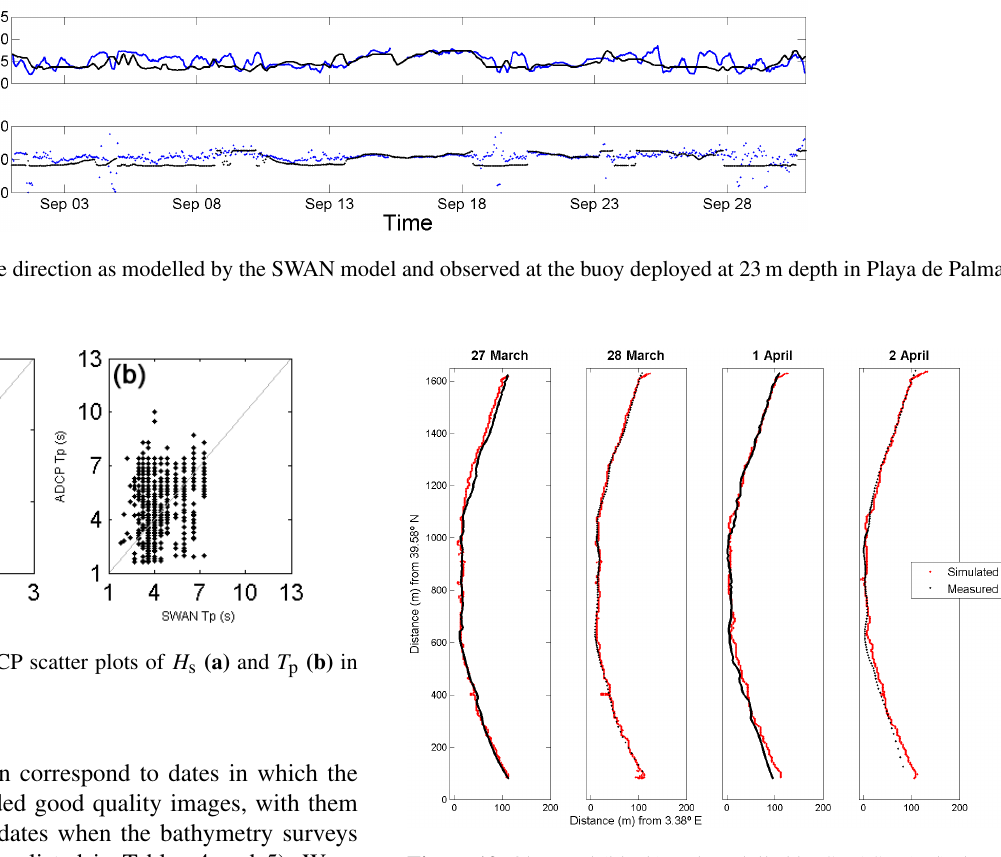
Figure 12. Observed (black) and modelled by SWASH (red) shore- line positions in Cala